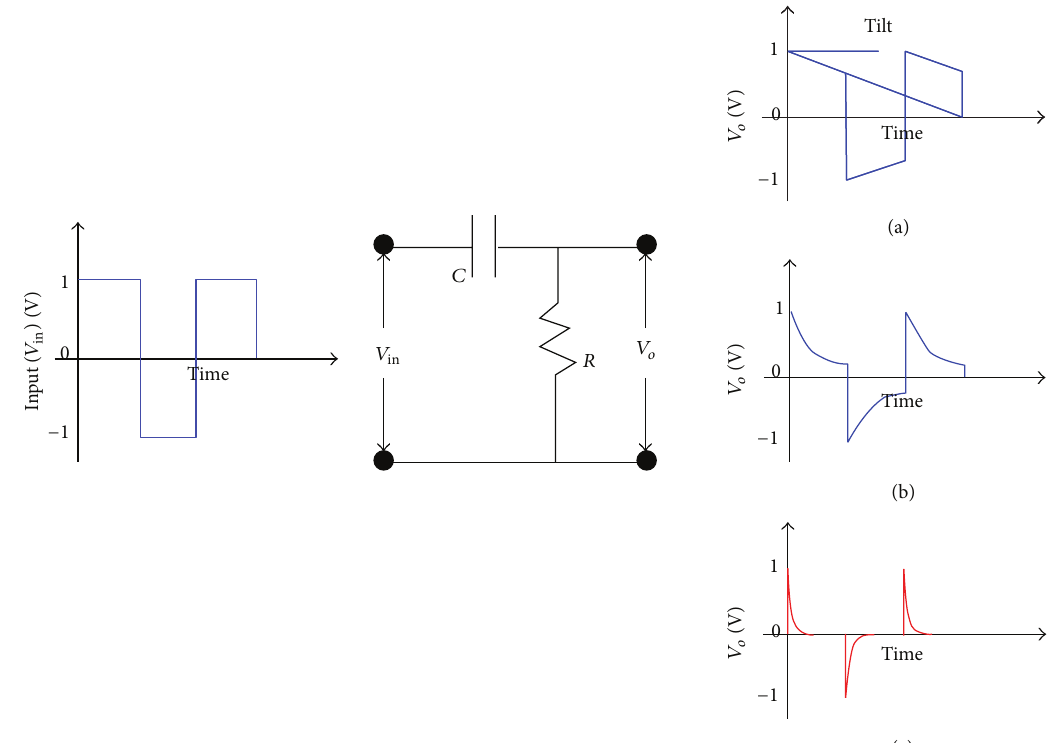
Figure 1: Effect of time constant of the RC circuit in the output waveforms: (a) high value of time constant, (b) medium value of time constant, and (c) very low value of time